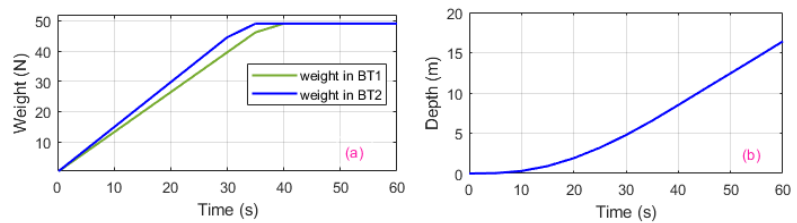
Figure 13. ( a ) Zoomed part of variation of the weight vs. time in both ballast tanks and ( b ) variation of depth with time in open loop.